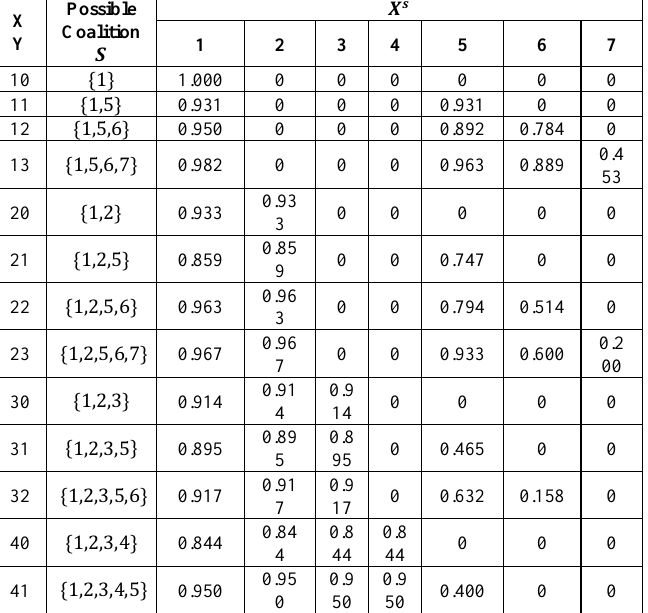
Table 5: Survival rates of the players in the existing coalitions (Restricted Approach, Good Years).